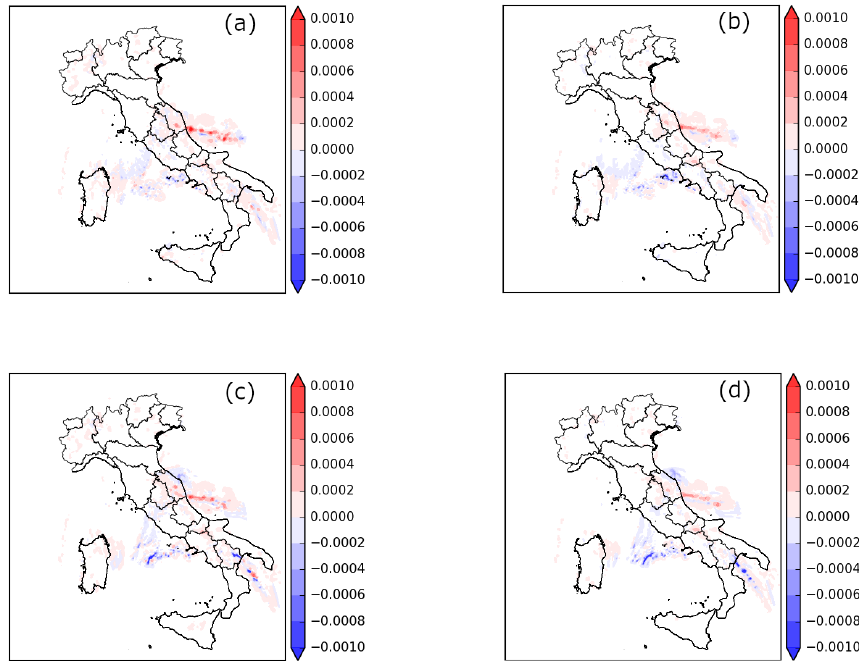
Figure 5. Rainwater mixing ratio (kgkg − 1 ) analysis increments at vertical level 15 from the CYC4DVAR_warm (a) , CYC3DVAR_warm (b) , CYC4DVAR_cold (c) and CYC3DVAR_cold (d)